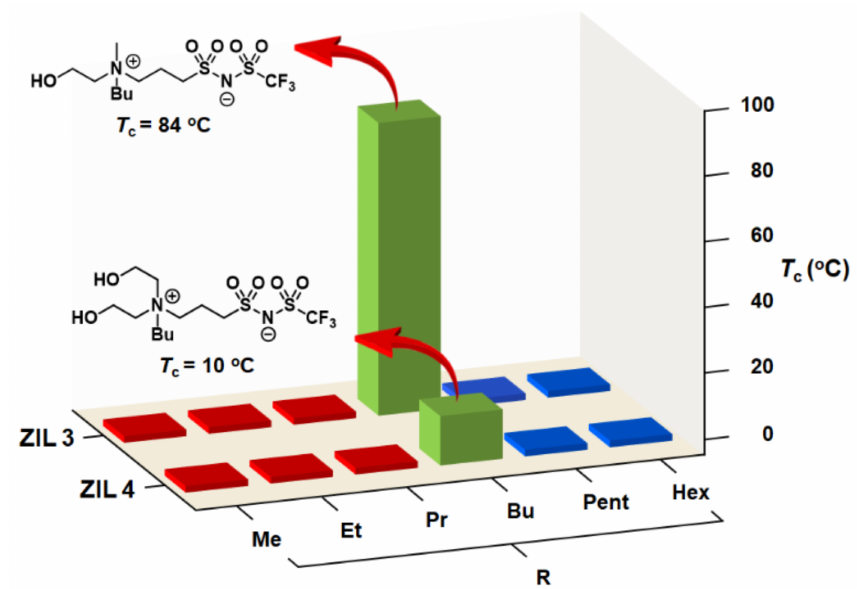
Figure 4. Phase transitions of a small library of 12 zwitterionic salts ( ZIL 3a–f and ZIL 4a–f ) upon mixing with water (1:1, w/w ) at temperatures between 0 ◦ C and 90 ◦ C. Phase transition results shown in red and blue indicate an entirely homogeneous (one-phase) solution and a heterogeneous (two- phase) mixture, respectively, between 0 ◦ C and 90 ◦ C. In the library, two room-temperature ionic liquids show phase transitions: ZIL 3d ( T c = 84 ◦ C) and ZIL 4d ( T c = 10 ◦